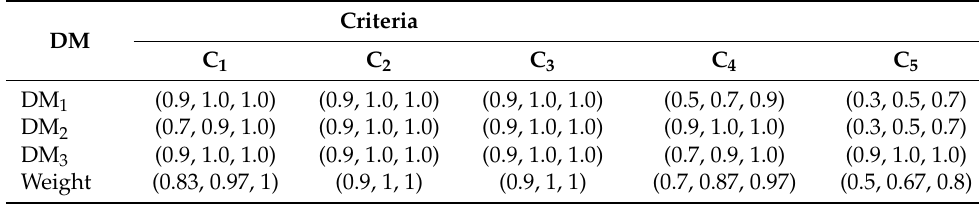
Table 16. Each criterion’s weight in TFN. DM